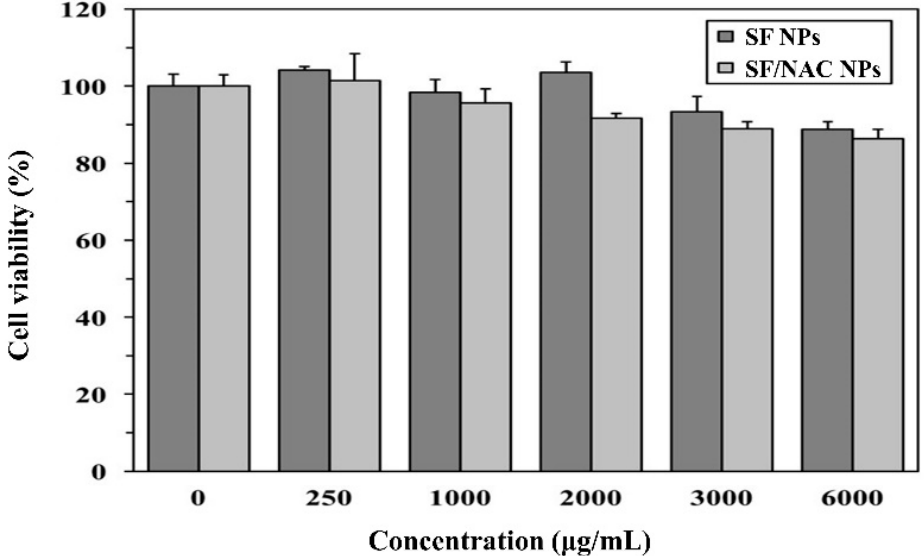
Figure 3. Cell viability studies for SF and SF/NAC NPs. The viability values (%) for the SF and SF/NAC NPs groups for concentrations of 0~6000 μ g/mL were significantly ( p < 0.01, n = 3, respec- tively) greater than 75%, the criteria for cytotoxicity evaluation of biomaterials of ISO10993-5. Hence, SF and SF/NAC NPs were biocompatible in these ranges.